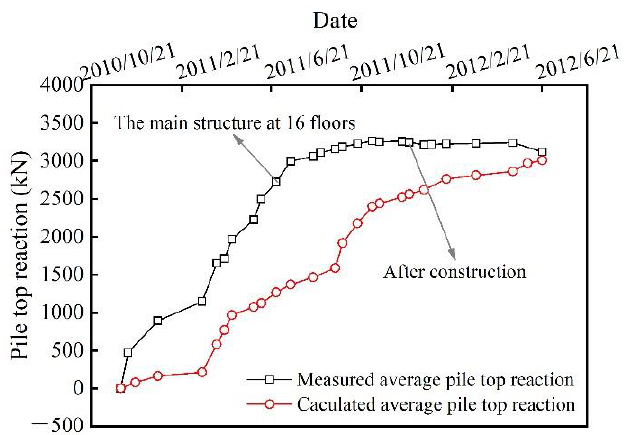
Figure 21. Curve of pile top reaction variation with time .